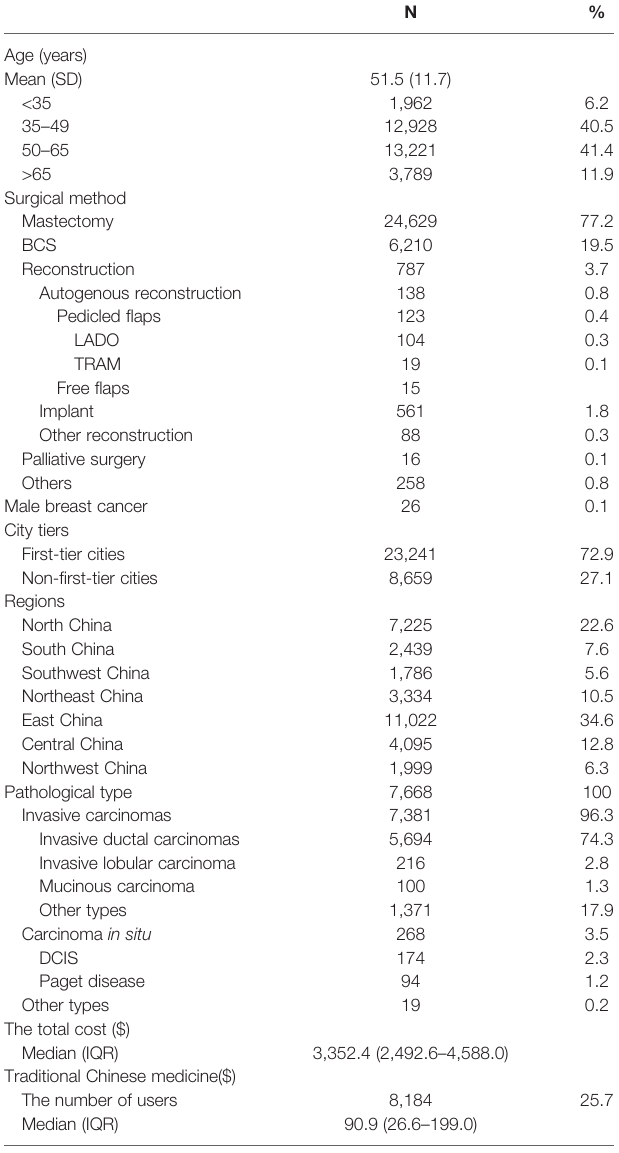
TABLE 1 | Characteristics of patients.